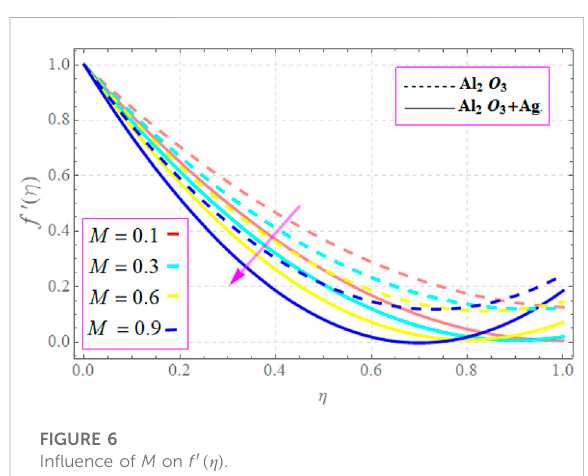
FIGURE 6 In fl uence of M on f ′ ( η ) .